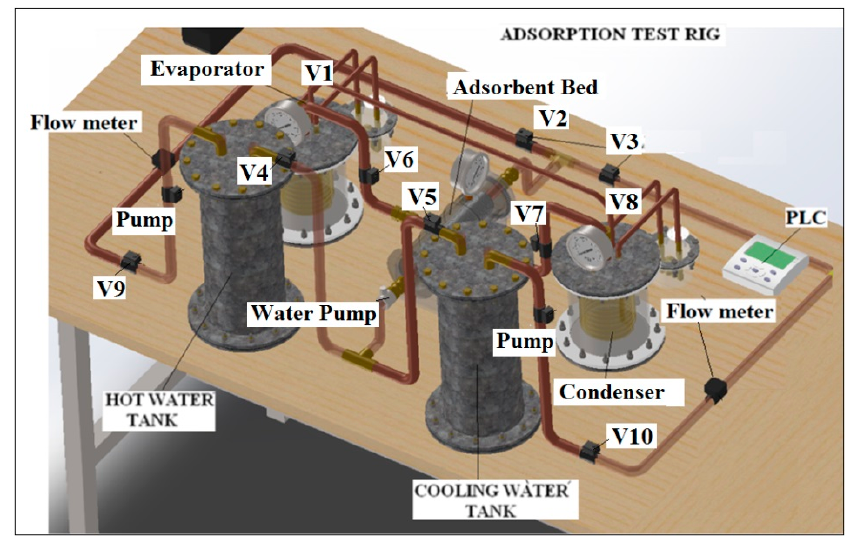
Figure 6. Helix copper coil heat exchanger (designed by J. White ©2012 [10]).